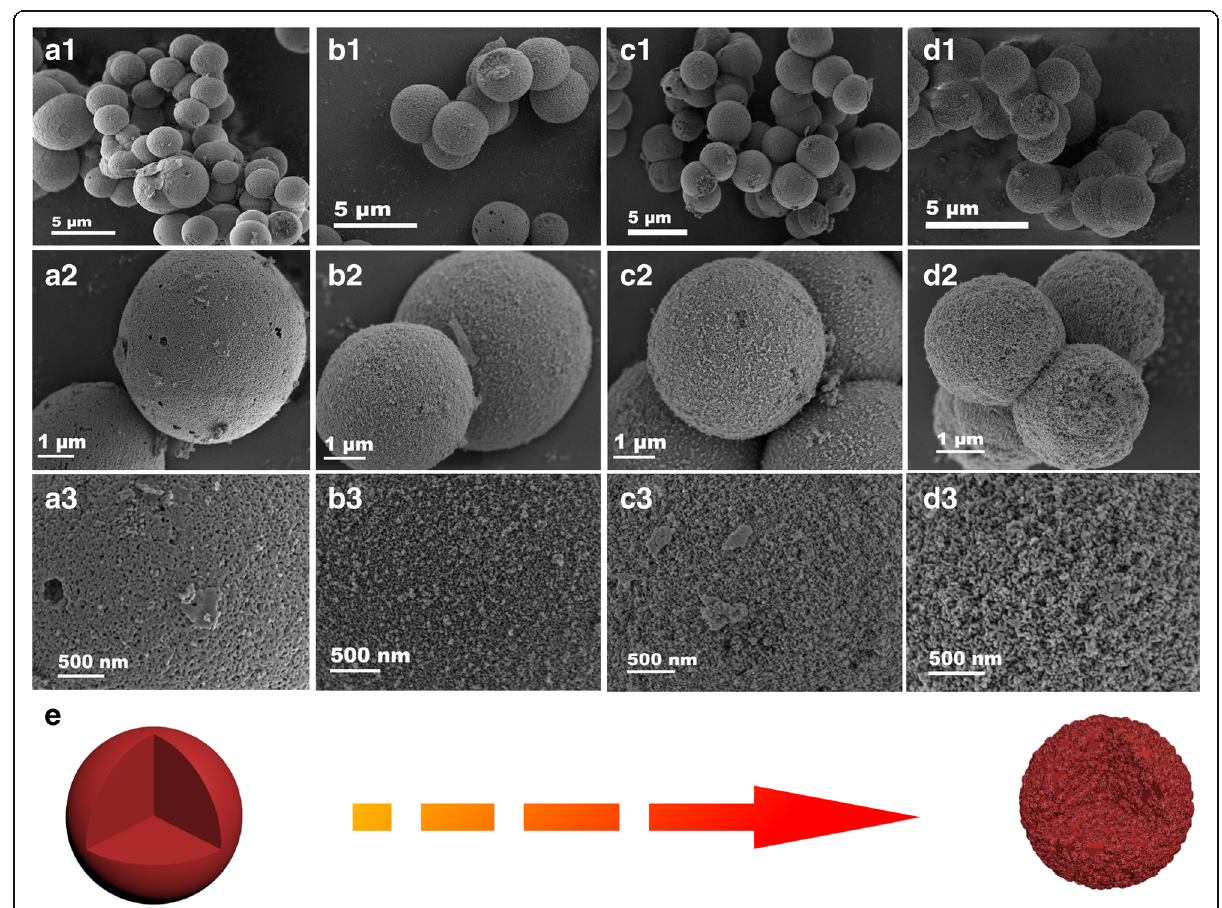
Fig. 3 Different resolution SEM images of S1 ( a1 – a3 ), S2 ( b1 – b3 ), S3 ( c1 – c3 ), and S4 ( d1 – d3 ). e Schematic diagram of the formation process from S1 to